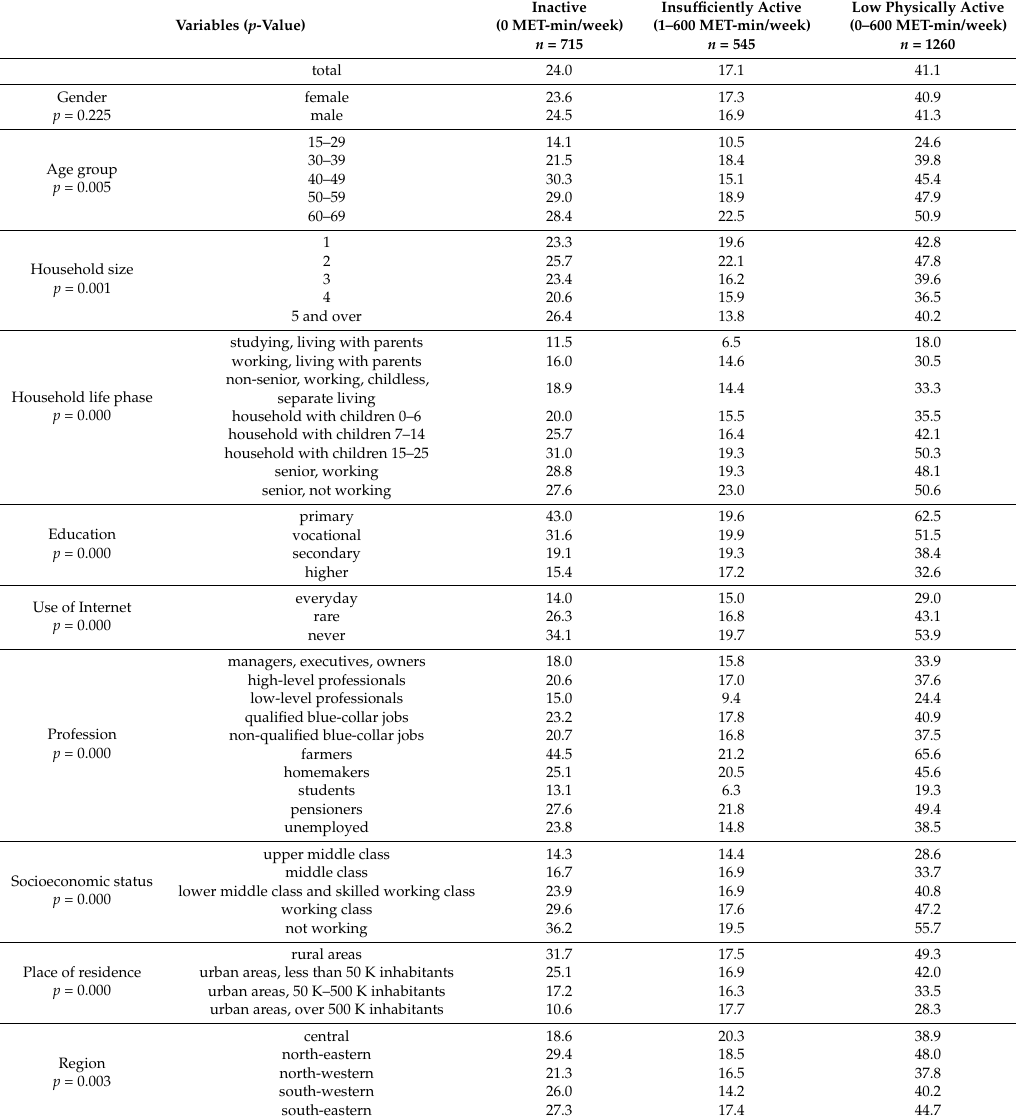
Table 2. Structure of physical inactivity and low activity in Poland (%). Variables ( p